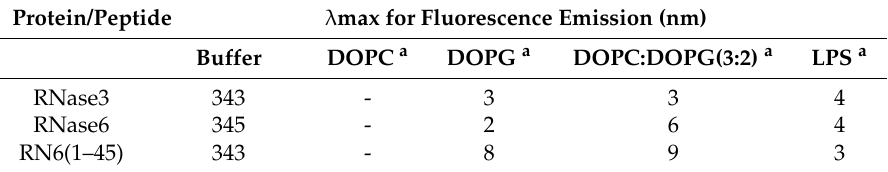
Table 1. Tryptophan fluorescence in the presence of lipid vesicles and LPS micelles for RNase3, RNase6 and RN6(1–45).